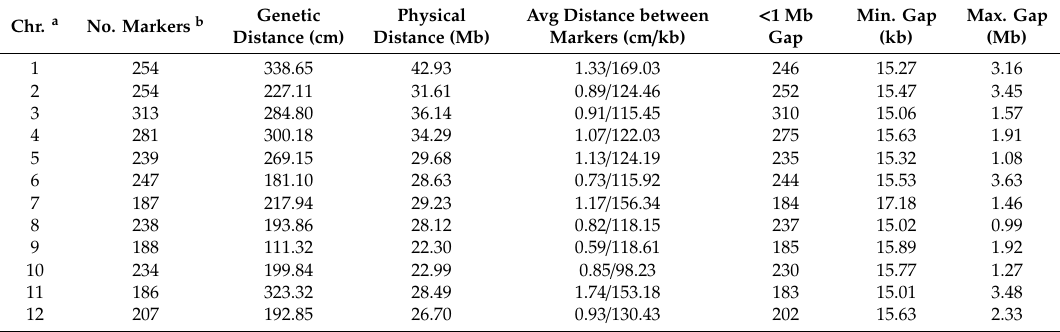
Table 1. Characteristics of the high-density genetic map derived from a cross between LTH and SN265. Chr. a